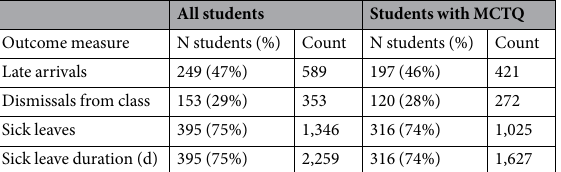
p = 0.0114), with males obtaining lower grades (on average 0.14 lower) compared to females. School attendance was found to be associated with grades, with increased absenteeism negatively impacting grades (late arrivals: b = − 0.062, t (407) = − 3.283, p = 0.0011; dismissals from class: b = − 0.090, t (407) = − 4.608, p < 0.0001; sick leave duration: b = − 0.019, t (407) = − 3.875, p = 0.0001). Our model predicted an overall decrease in grades of 0.09 for a student dismissed from class one time, a decrease of 0.06 for a student arriving late one time, and a decrease of 0.02 for a student being sick one day in the course of an entire school year. To compare the strength of the effects of this set of predictors, we calculated the standardised beta ( β ) coefficients (Fig. 1). The effect on grades was stronger for dismissals from class ( β = − 0.087), followed by sick leave duration ( β = − 0.065), late arrivals ( β = − 0.061), sex ( β = − 0.044), and chronotype ( β = − 0.042). Short sleep duration was found to be significantly associated with lower grades only in model 9 (b = 0.083, t (423) = 2.943, p = 0.0034). This model did not include the school attendance variables as predictors and had the highest AIC value (worse fit) among all models considered. Similarly, increased levels of social jetlag were signif- icantly associated with lower grades only in model 8 (b = − 0.094, t (409) = − 3.188, p = 0.0015), which did not include the school attendance variables as predictors. The mediation analysis showed that the direct effect of chronotype on grades was significant (late arrivals: b = − 0.085, p = 0.01; dismissals from class: b = − 0.071, p = 0.01; sick leave (duration): b = − 0.087, p < 0.01; sleep duration on school days: b = − 0.081, p < 0.01), while the indirect effect of chronotype mediated by late arrivals, dismissals from class, sick leave (duration), and sleep duration on school days was not (late arrivals: b = − 0.005,